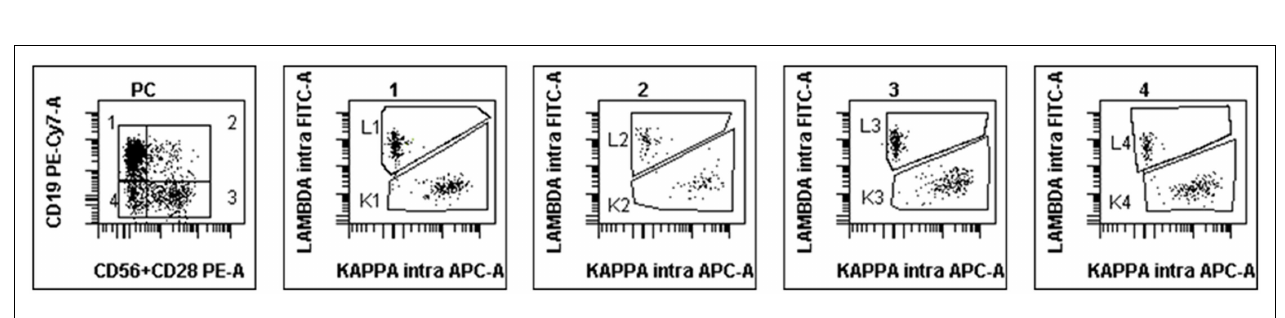
subgroup 1 but cells can also be seen in the other compartments. Polyclonality is confirmed by the investigation of cytoplasmic light chains in the four subsequent scattergrams gated on groups 1–4 from left to